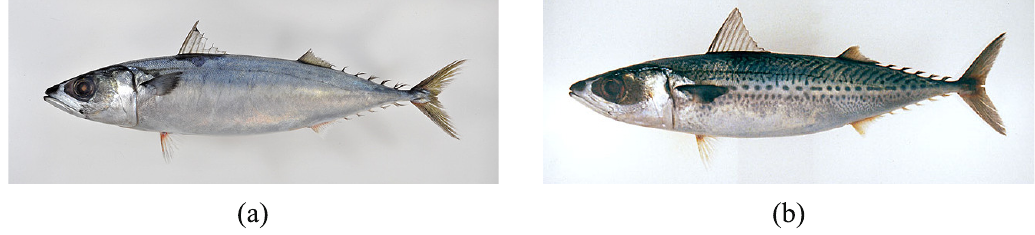
Figure 1. Two major mackerel species caught on Japanese coasts. ( a ) Scomber japonicus (chub mackerel); ( b ) Scomber australasicus (blue